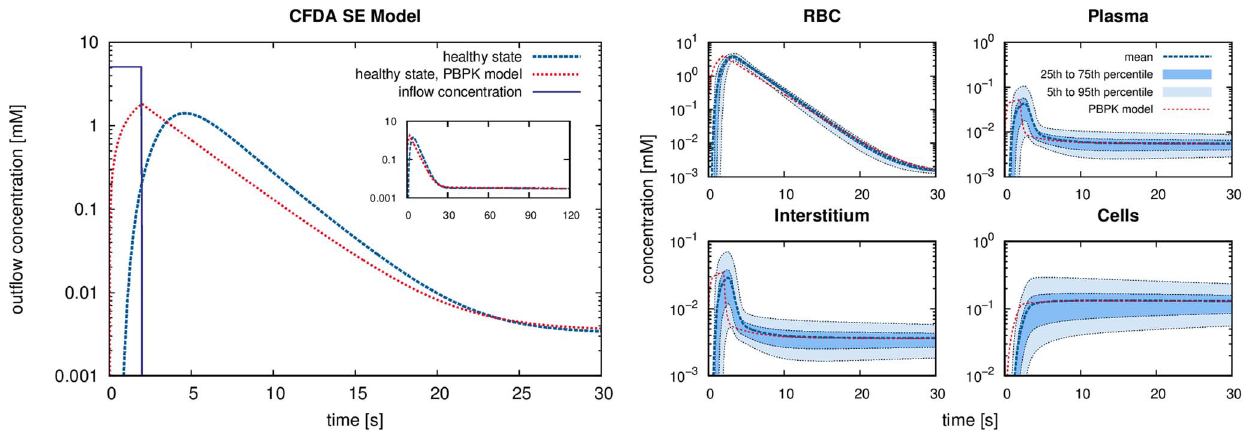
Figure 6. Results of the single pass perfusion of CFDA SE (outflow concentrations). For perfusion by CFDA SE, the large plot (left) shows the outflowing CFDA SE concentration in the healthy state of the isolated mouse liver model and the two steatotic states for a CFDA SE inflow during 2 seconds. For comparison, results for a PBPK simulation are shown as well. The four small plots (right) show the mean CFDA SE concentrations in the four subspaces of the homogenized hepatic space as well as the ranges between 5th/95th and 25th/75th percentiles, respectively, to illustrate the ranges of the concentrations in the spatially resolved model. The PBPK simulation results, shown for comparison, in contrast yield one value for each compartment at any given time point, representing only mean values.